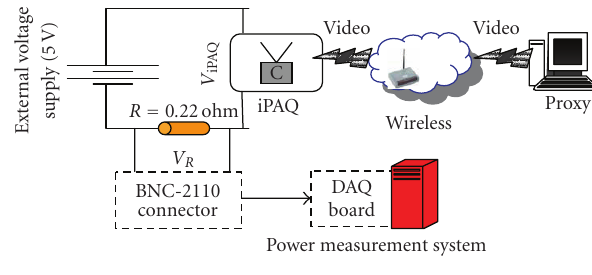
Algorithm 1: Exhaustive algorithm for finding Alfa ∗ .